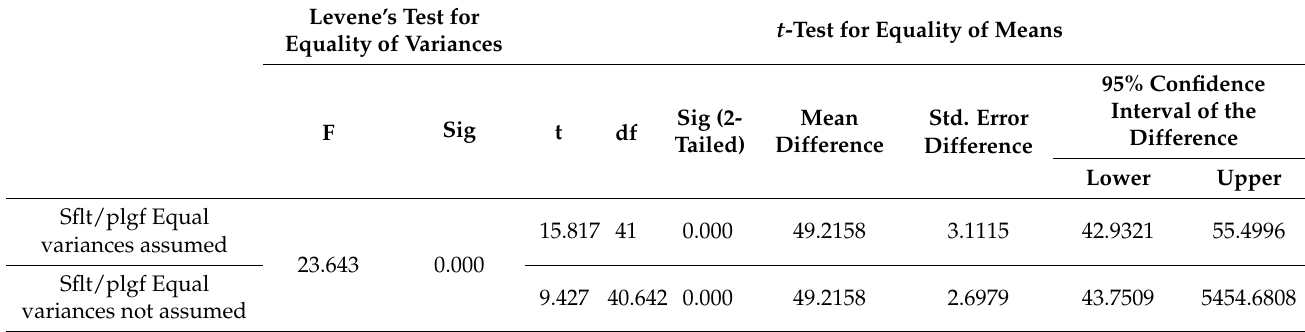
Table 2. Independent t -test for severe PE and hypertension.